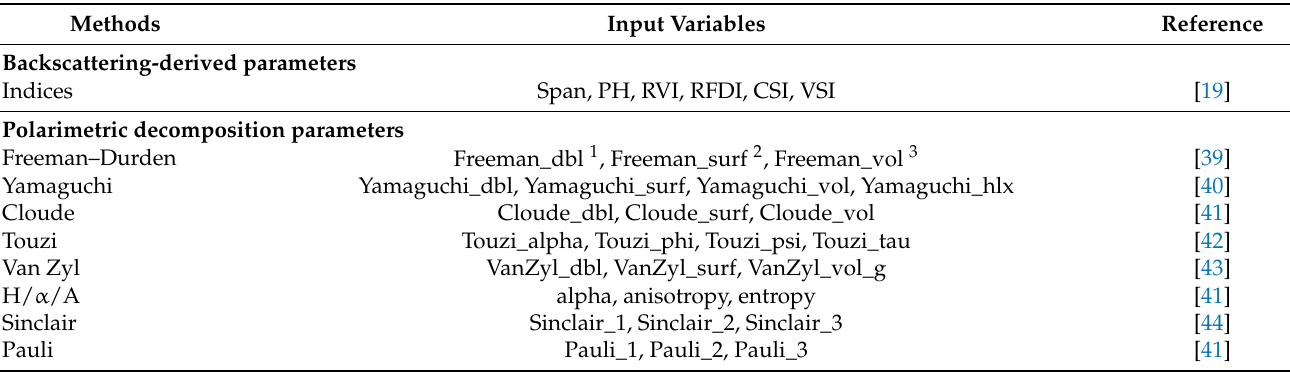
Table 2. Summary of the input variables of the random forest (RF) model used in the modeling of PWN infestation from Radarsat-2 image. The variables are comprised of backscattering-derived parameters and polarimetric decomposition parameters.